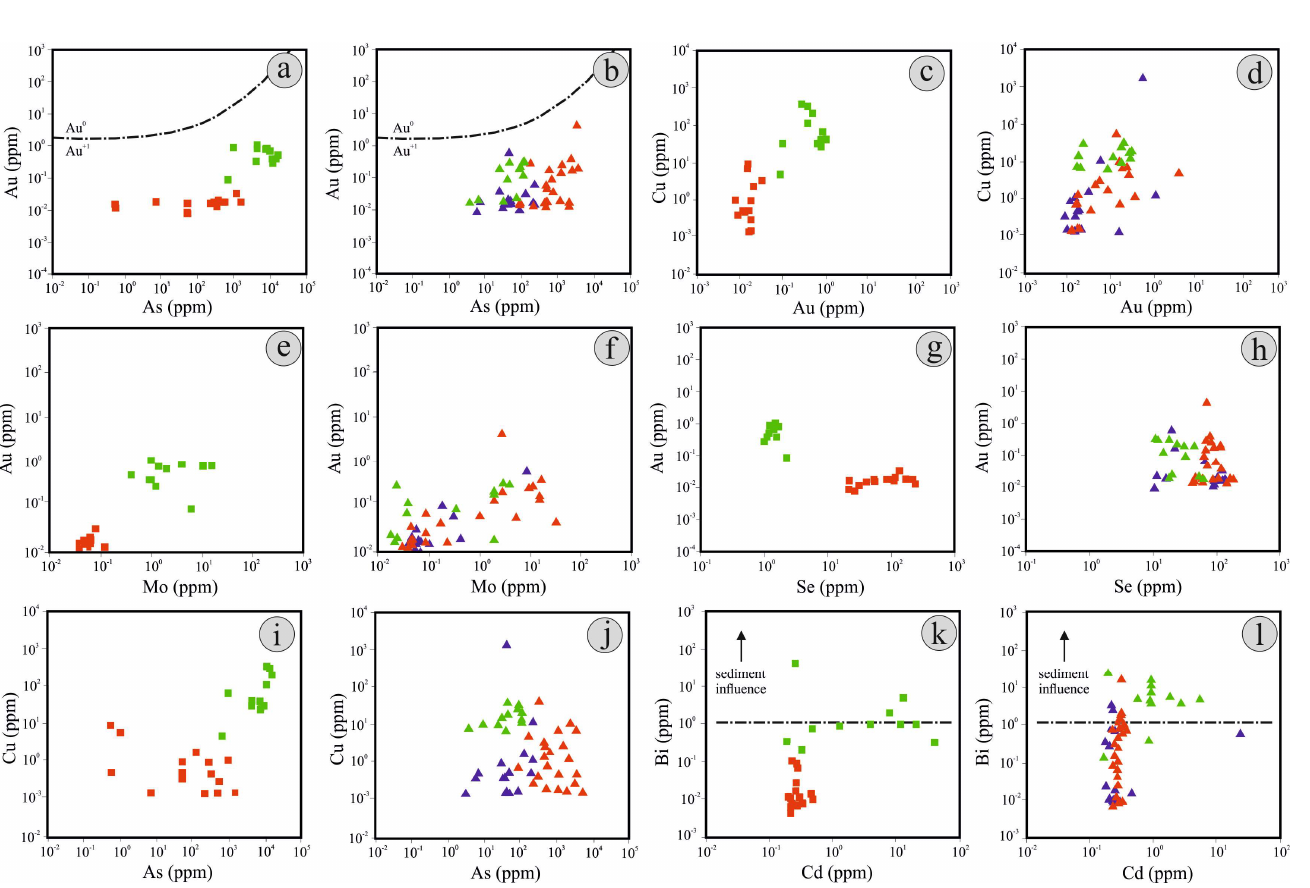
Figure 9. Trace elements variation plots of pyrite from different mineralization events at the Konos Hill ( a , c , e , g , i , and k ) and the Pagoni Rachi ( b , d , f , h , j , and l ) porphyry-epithermal prospects (same symbols as in Figure 8; values in ppm). ( a , b ) As versus Au. The black, dash-dotted curve represents the solubility limit of Au as a function of As concentration [8]; ( c , d ) Au versus Cu; ( e , f ) Mo versus Au; ( g , h ) Se versus Au; ( i , j ) As versus Cu; ( k , l ) Bi versus Cd, adopted from Keith et al. [7]. The maximum Bi value of 7451 ppm, attributed to Bi-bearing inclusion, has been excluded from the plot in 9l.